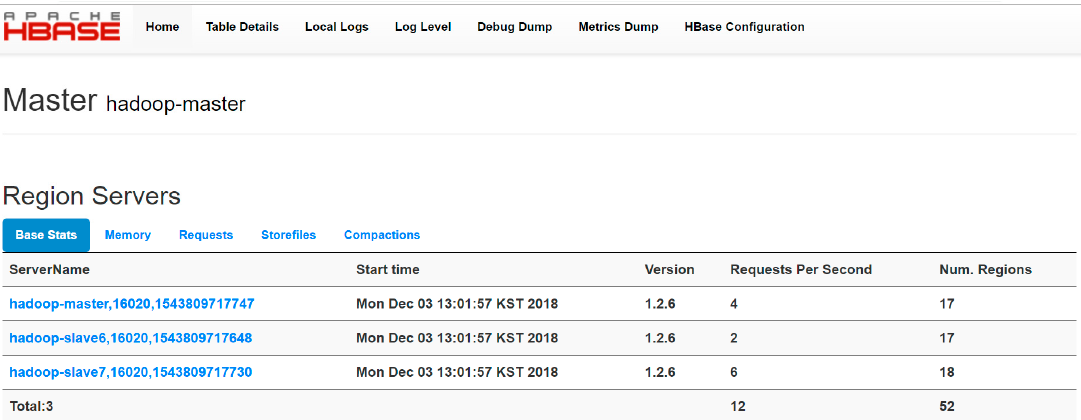
Figure 11. Hadoop Cluster Installation and Information.